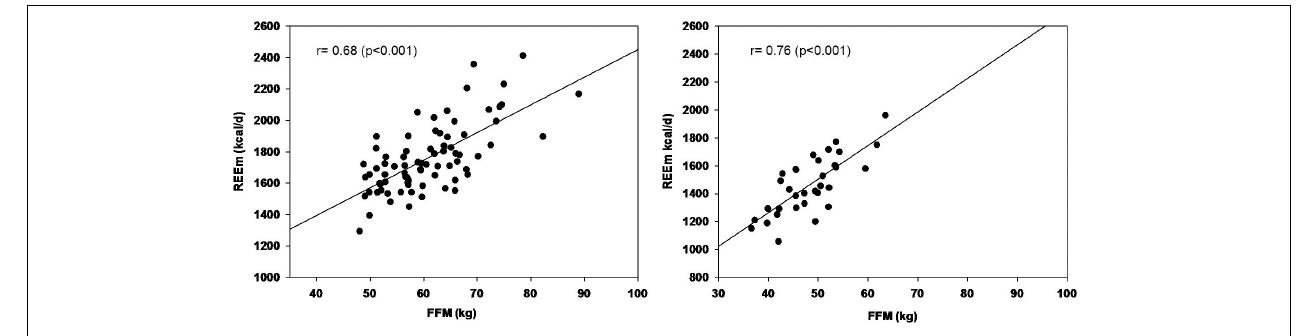
FIGURE 4 | Relationship between the measured resting energy expenditure (REEm) and fat free mass (FFM) of master athletes. On the left: men ( r = 0.69, p < 0.001), on the right: women ( r = 0.76, p < 0.001).